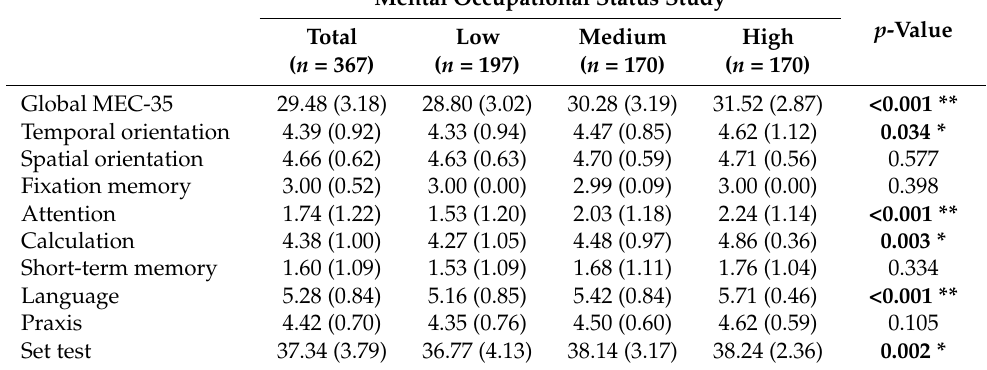
Table 3. Differential cognitive characteristics per mental occupational status (mean + standard